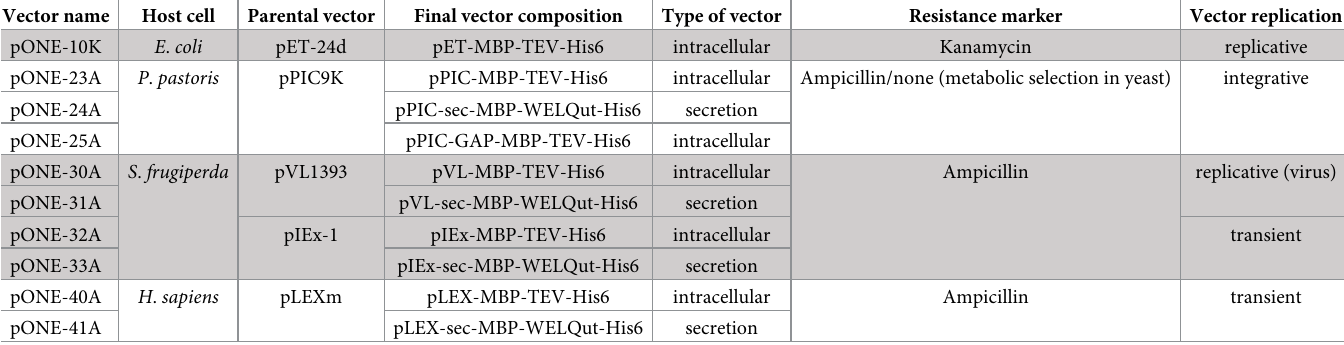
Table 1. The list of unified vectors of the pONE